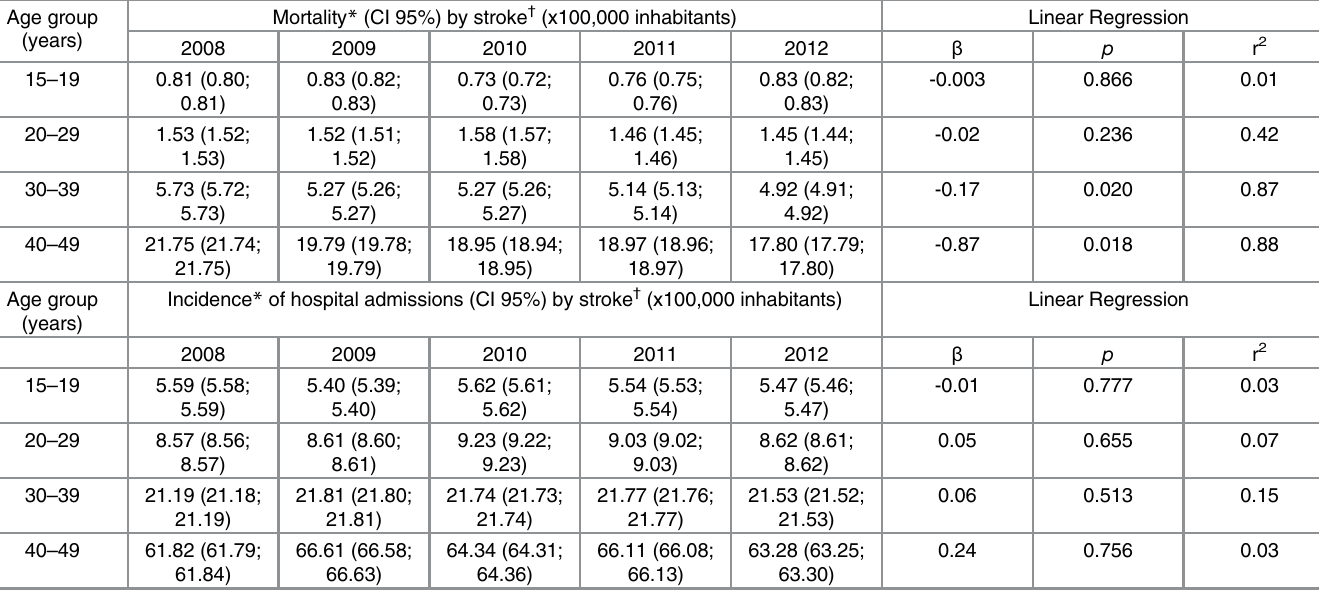
Table 3. Mortality * and incidence * of hospital admissions for stroke † (95% confidence interval) per 100,000 inhabitants; and estimates of linear regression (referring to the rates) in Brazilians from 15 to 49 years between 2008 and 2012, by age group and year. Age group (years)